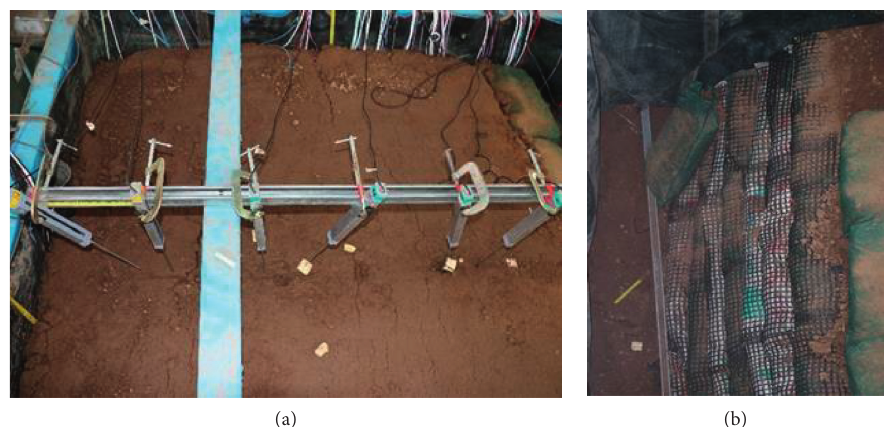
Figure 4: Final deformation. (a) Deformation of slope top. (b) Deformation of slope.